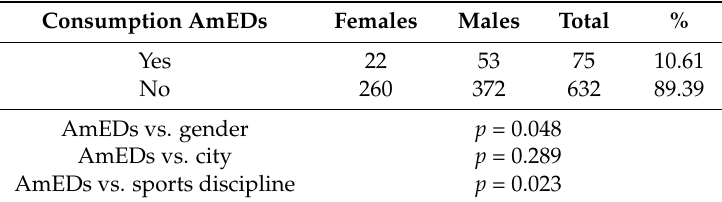
Table 6. Consumption of energy drinks mixed with alcohol (AmEDs) by secondary sports school students ( n =